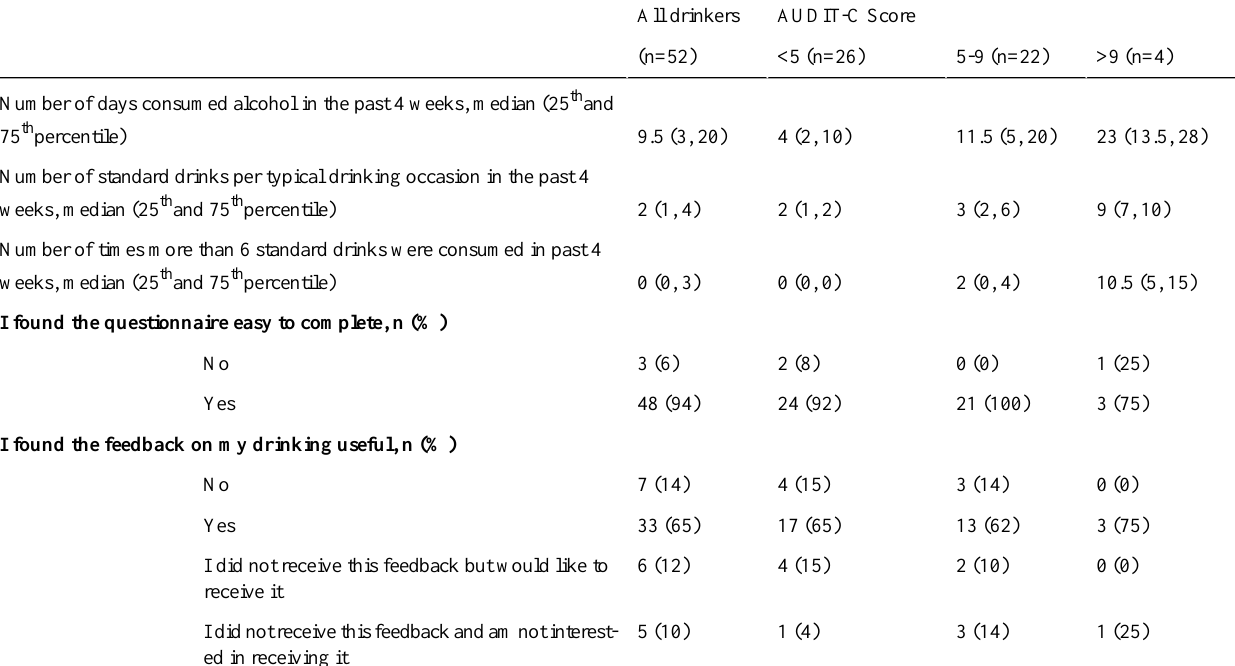
Table 3. Alcohol consumption and acceptability of e-SBI at follow-up.